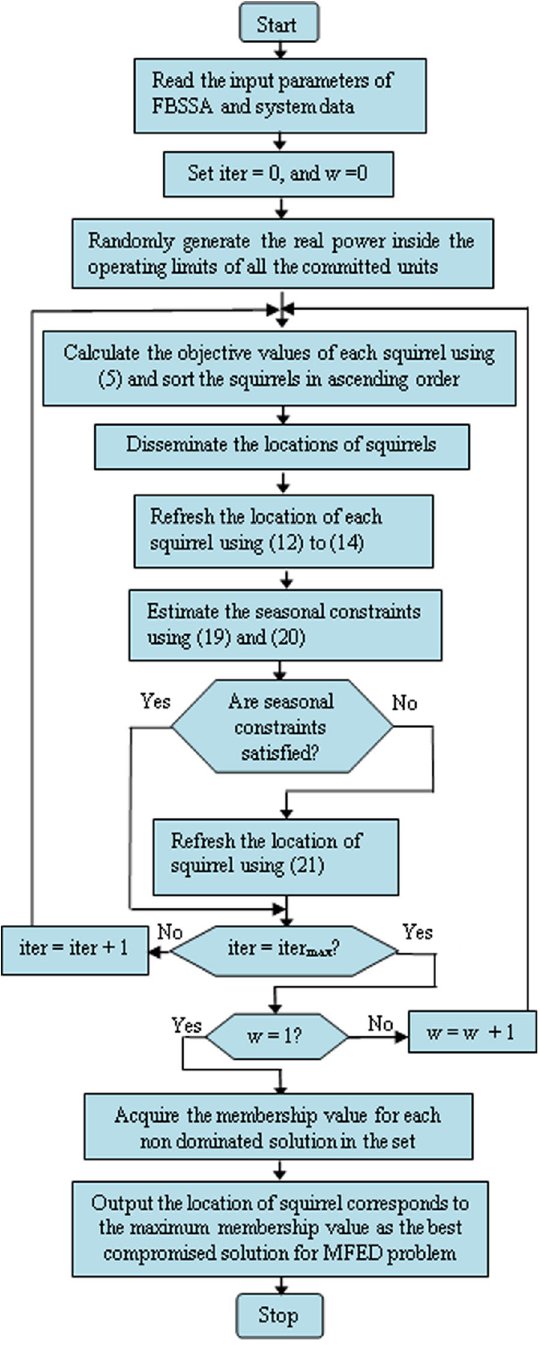
Fig. 2 Flow chart of FSSA algorithm for solving the MFED problem